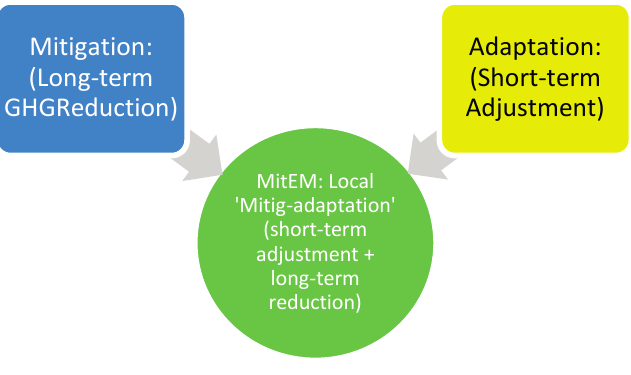
Figure 1. Proposed approach as intersection between mitigation and